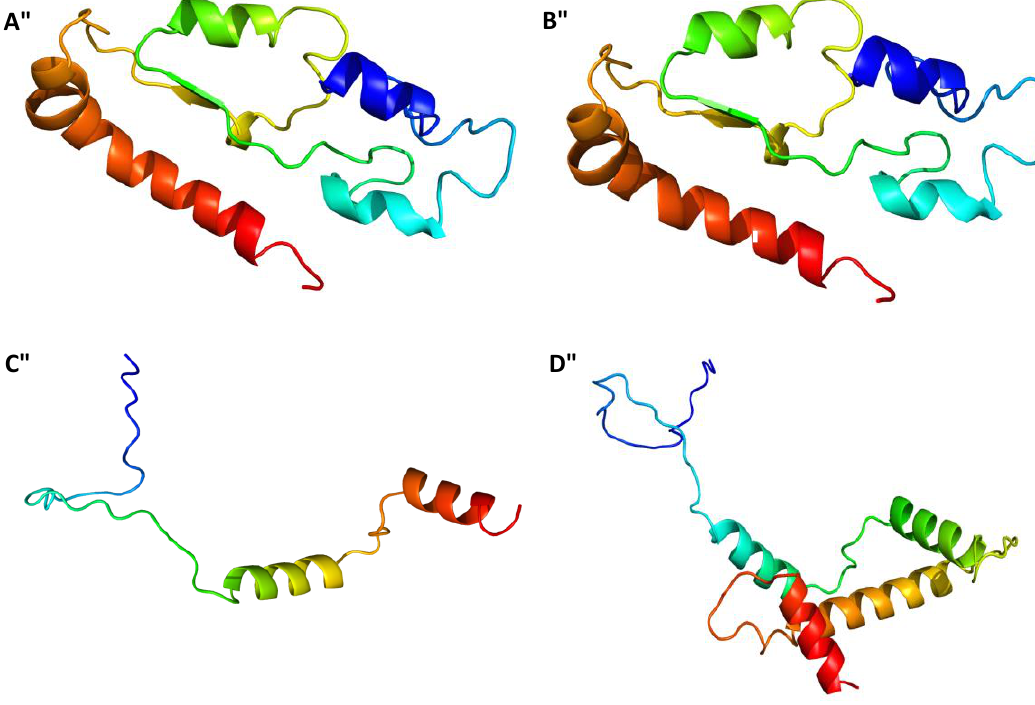
Figure 4. Three-dimensional model predicted for β -tubulin from: A— C. nymphaeae isolates from groups A and B and B— C. nymphaeae isolates from group D; HIS-3 from: C— C. nymphaeae isolates from groups A and B and D— C. nymphaeae isolate from group C. The models of beta tubulin were based on a three-dimensional model of the human monomeric kinesin and bovine tubulin as template (Phyre2 fold library ID: c2p4nB) and the models of HIS-3 were based on a three-dimensional model of the “Chicken” ( Gallus gallus ) as template (Phyre2 fold library ID: d1eqzg). The N-terminal is represented in blue and the C-terminal in red.